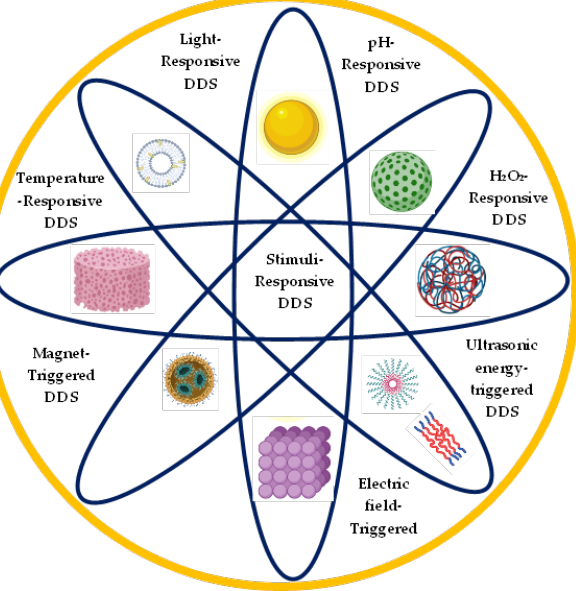
Figure 1. Schematic diagram of different stimuli-responsive ocular drug delivery systems and different nanomaterials used in ocular drug delivery. Adapted from [15]. 2022, Elsevier Under Creative Commons license.